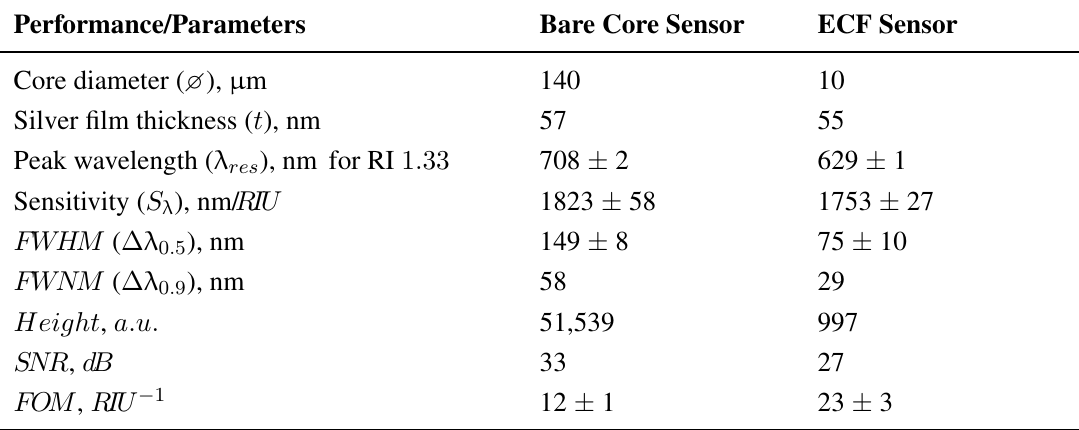
Table 1. SPR performance characteristics of the bare core fibre sensor and the exposed core fibre (ECF)